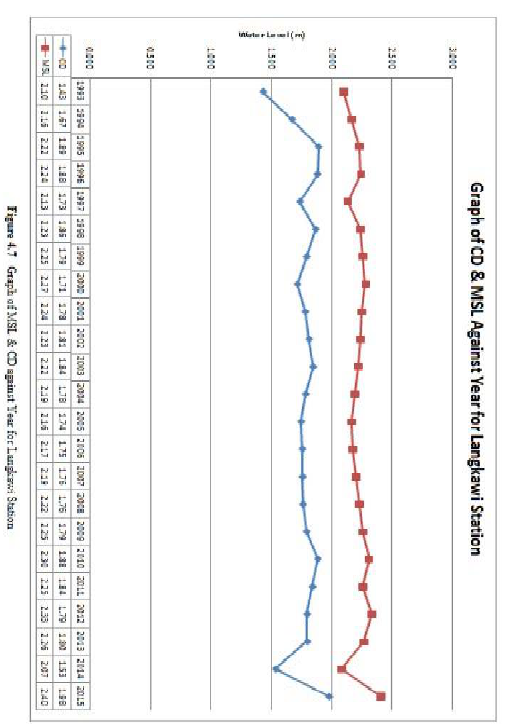
Figure 13. Langkawi Tide Station